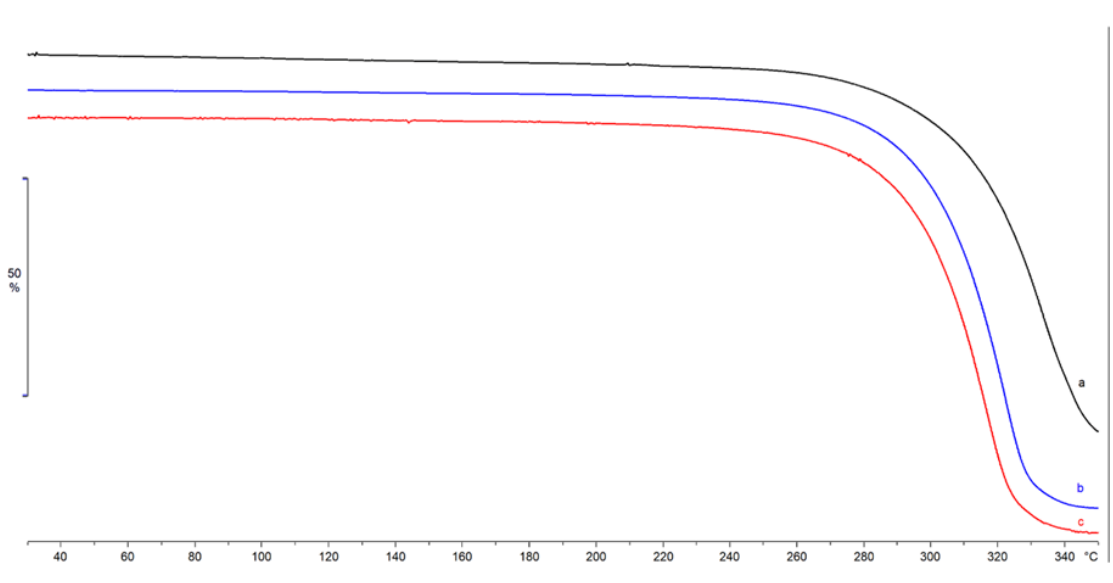
Figure 3. TGA profiles of Lyosecretome batches 1, 2, and 3 (curves a, b, and c). Morphological investigation through SEM images showed that vesicles integrity and